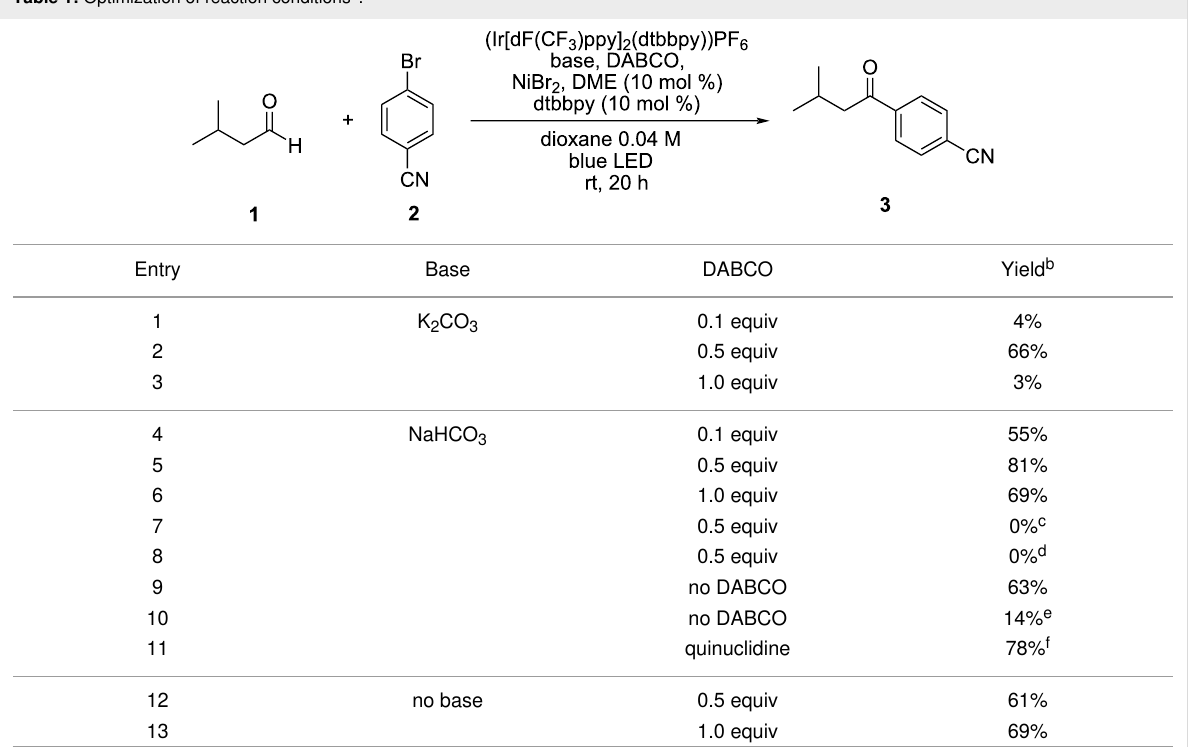
Table 1: Optimization of reaction conditions a